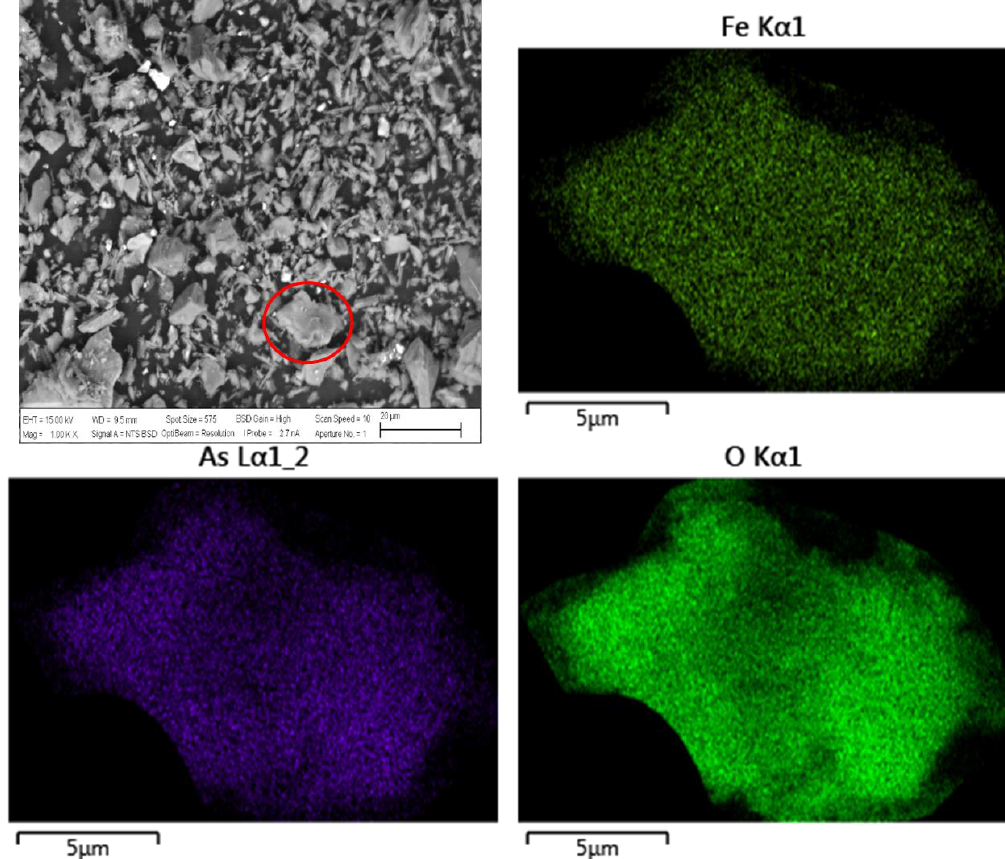
Figure 7. SEM-BSE image for leaching residues ( × 1000) and the SEM-EDS for the particle in the red circle ( × 5500).